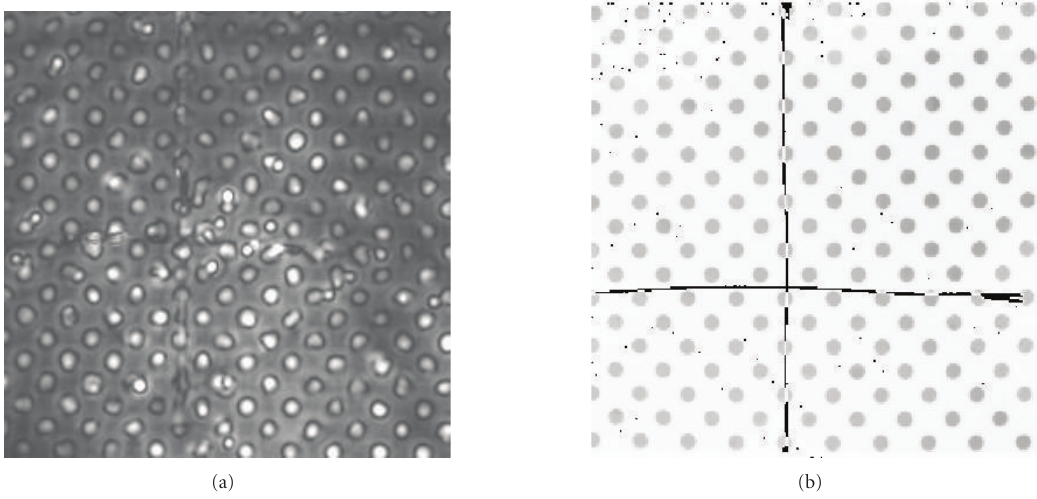
Figure 3: Images of the phantom used to create the matrix of control points: (a) VA image; (b) X-ray image.